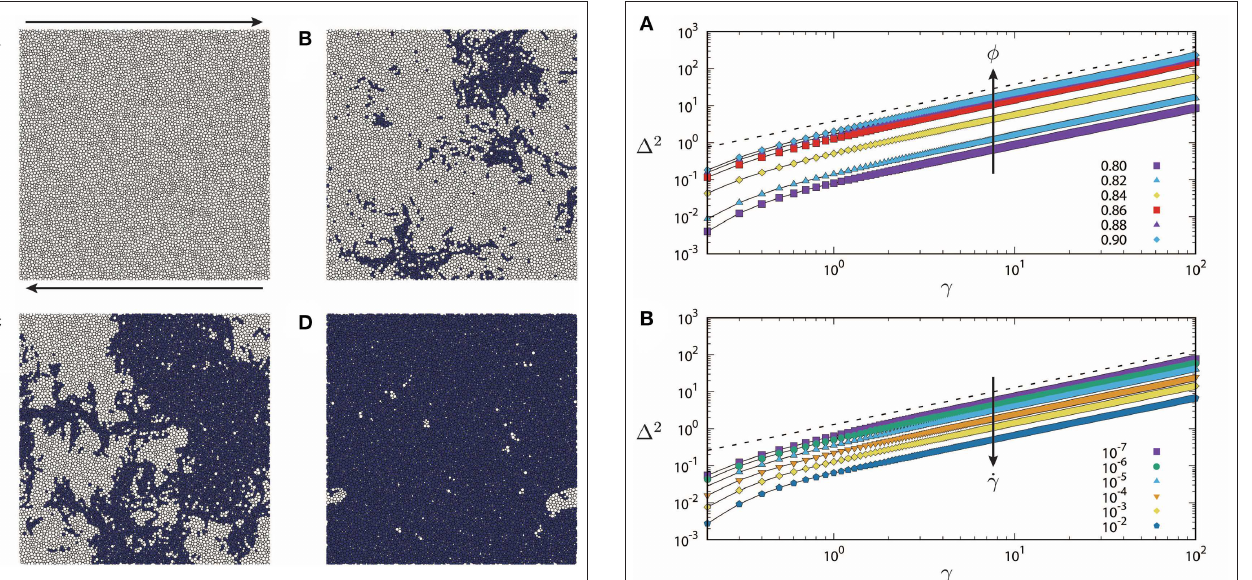
FIGURE 2 | The transverse MSDs 1 2 (Equation 2) as functions of the shear strain γ ≡ ˙ γτ . (A) The packing fraction φ increases as indicated by the arrow and listed in the legend, where the shear rate is ˙ γ = 10 − 6 t − 1 0 . (B) The shear rate ˙ γ increases as indicated by the arrow and listed in the legend, where the packing fraction is φ =